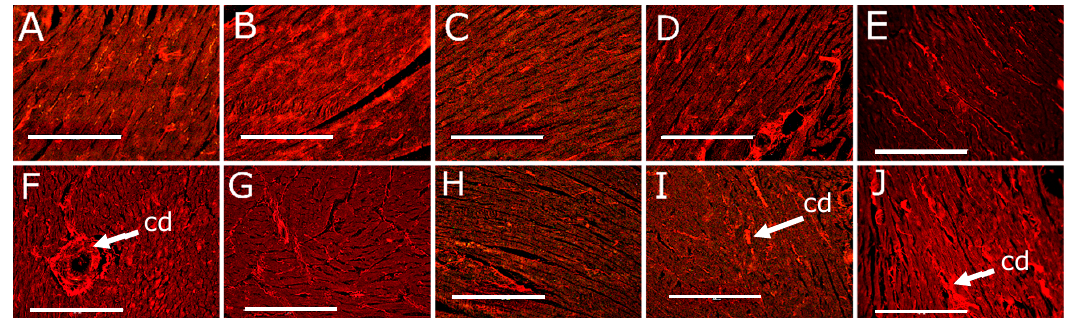
Figure 2. E ff ects of curcumin on collagen deposition (“cd”) in the heart using picrosirius red stain in corn starch diet-fed rats ( A ), corn starch diet-fed rats given 5 mg / kg / day curcumin ( B ), corn starch diet-fed rats given 100 mg / kg / day curcumin ( C ), corn starch diet-fed rats given 5 mg / kg / day curcumin nanoparticles ( D ), corn starch diet-fed rats given blank nanoparticles ( E ), high-carbohydrate, high-fat diet-fed rats ( F ), high-carbohydrate, high-fat diet-fed rats given 5 mg / kg / day curcumin ( G ), high-carbohydrate, high-fat diet-fed rats given 100 mg / kg / day curcumin ( H ), high-carbohydrate, high-fat diet-fed rats given 5 mg / kg / day curcumin nanoparticles ( I ) and high-carbohydrate, high-fat diet-fed rats given blank nanoparticles ( J ). The white bar is 200 µ m.